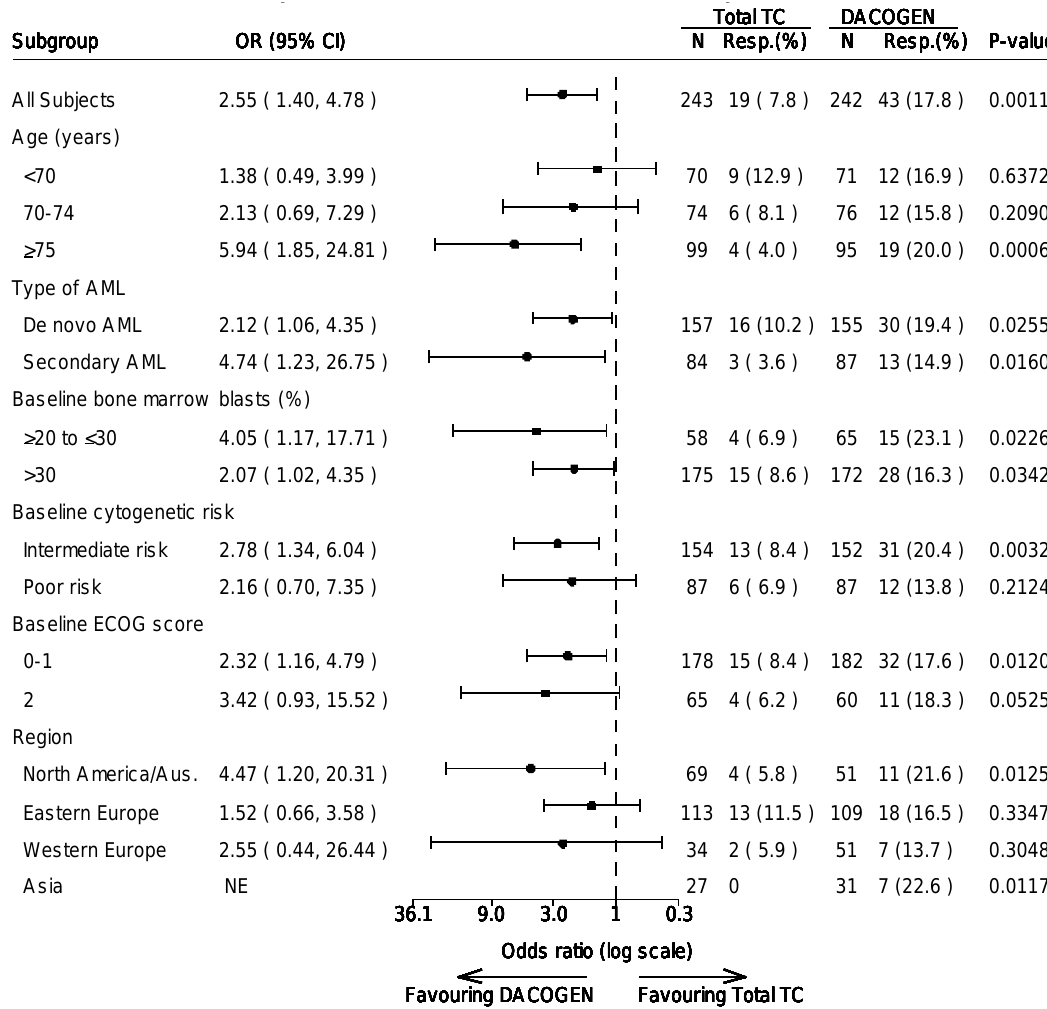
Figure 7: Response Subgroup Analysis of Subjects With Complete Remission or Complete Remission With Incomplete Platelet Recovery (Study DACO-016) (Intent-to-Treat Analysis Population)